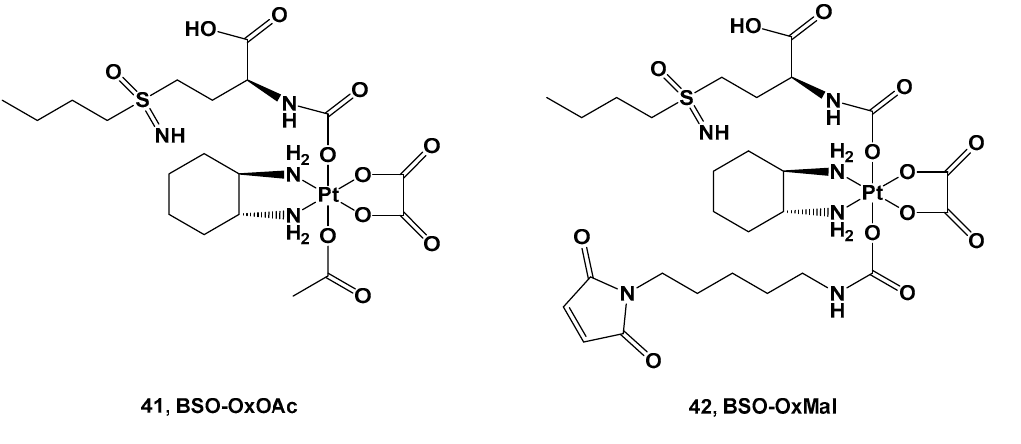
Figure 15. Pt(IV) complexes 41 and 42 .